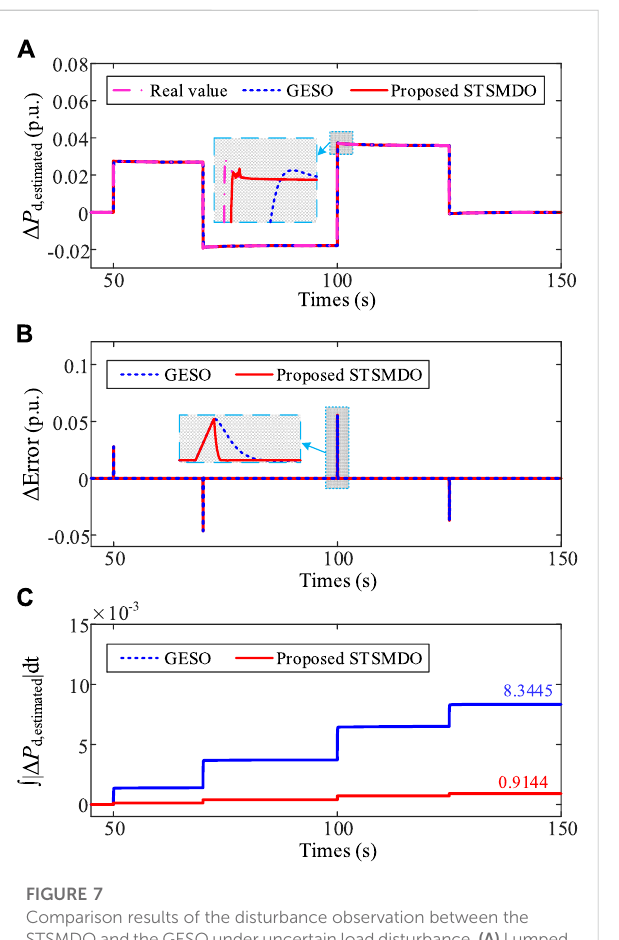
FIGURE 8 Comparisonresultsofthesystemfrequency fl uctuationbetween the STSMFC and the OFC under uncertain load disturbance. (A) System frequency fl uctuation. (B) Total frequency fl uctuation level , | Δ f |dt. (C) Wind power